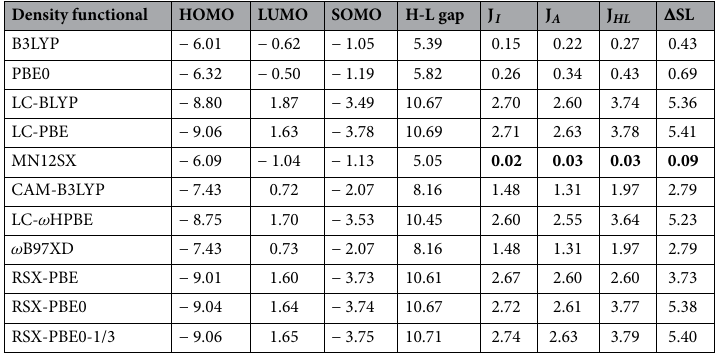
Table 4. The orbital energies (HOMO, LUMO and SOMO), the resulting HOMO-LUMO gap and the KID indices (all in eV) for the Aspergillipeptide D marine cyclopentapeptide. Data in bold indicates values of significance.